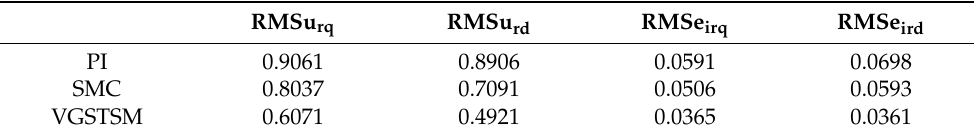
Figure 16. Adaptive gains. Table 2. Root mean square (RMS) for tracking errors and control